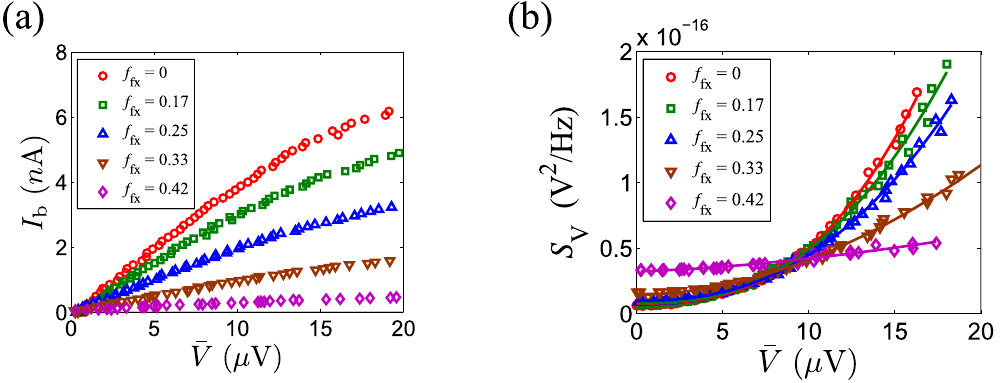
Figure 4. Measurement results ( a ) Measured mean voltage V as a function of the bias current I b and ( b ) Zero- frequency voltage noise spectrum S V (0) as a function of mean voltage V for sample JJ1. Both plots show curves for flux filling factors f fx of 0, 0.17, 0.25, 0.33 and 0.42. Various open symbols are the measured data and the solid curves in ( b ) are power low fitting to the